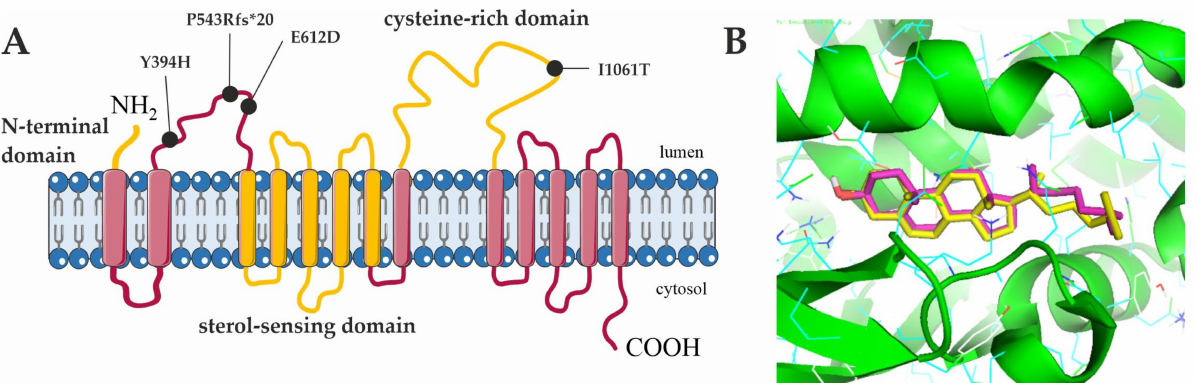
Figure 1. Scheme of the docking experiment. ( A ) Schematic representation of the NPC1 protein, showing three important domains in yellow: N-terminal domain, sterol-sensing domain, and cysteine- rich domain. The approximate locations of the NPC1 variants used in this study are indicated. ( B ) The comparison of the docked cholesterol (magenta) and the cholesterol from the crystal complex (yellow) revealed a similar binding pose, demonstrating that the docking simulation generates a reliable